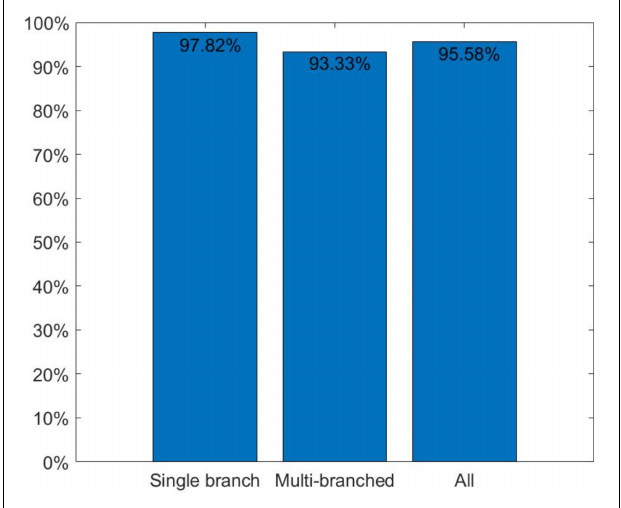
FIGURE 9 | Branch judgment